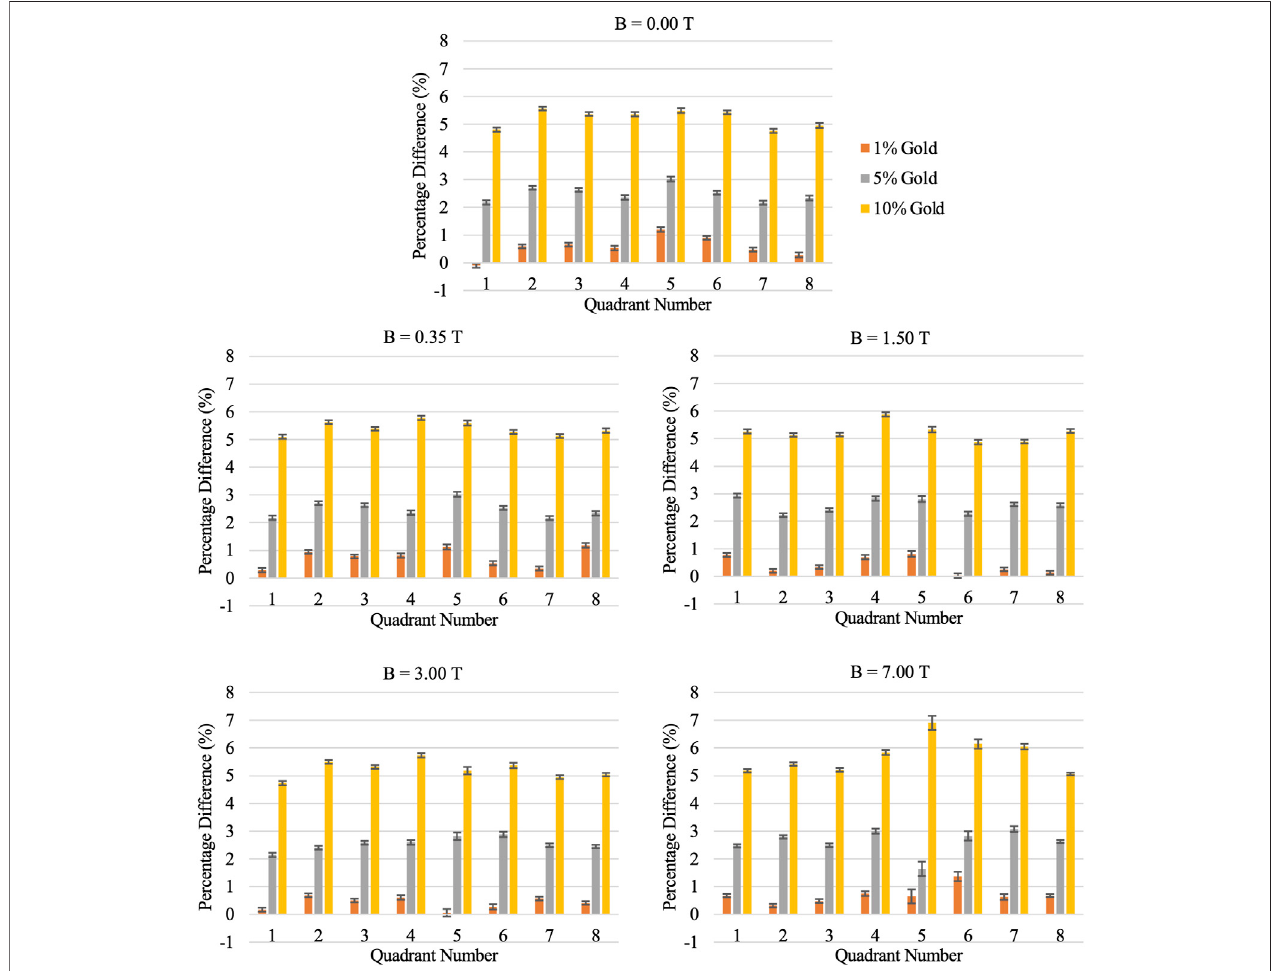
FIGURE 5 | Percentage difference in energy deposition in alveolus water shell with and without integration of nanoparticles at varying magnetic fi eld strength.